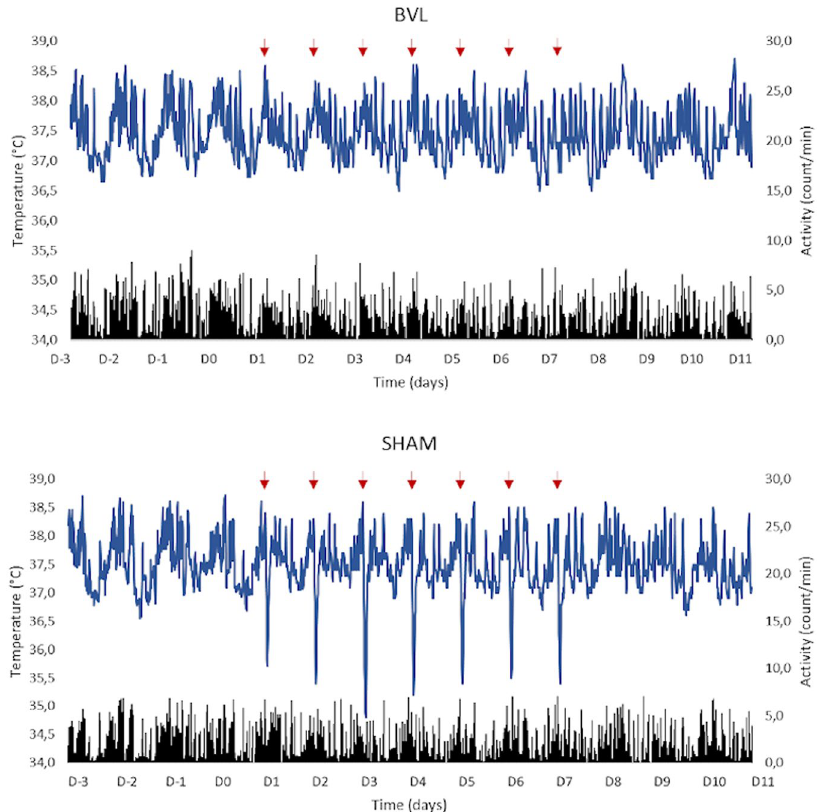
Figure 4. Response of BVL rats and sham rats to 2 G stimulations. Representative examples of a BVL (upper figure) and a sham rat (lower figure). The blue line represents the Tc curve, and the black bars represent locomotor activity (LMA). D-3 to D0 represents the end of the baseline recordings, and 2 G pulses started at D1. Each red arrow represents a one-hour 2 G pulse, which caused a sudden and transient drop of temperature in sham rats. For more clarity, this figure only represents three days before 2 G pulses, the seven daily 2 G pulses, and three days after 2 G pulses.